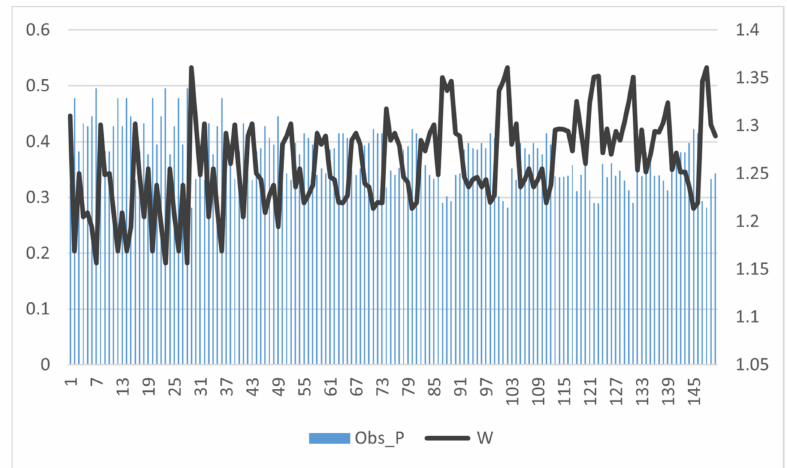
Figure 6. Function variation plot.